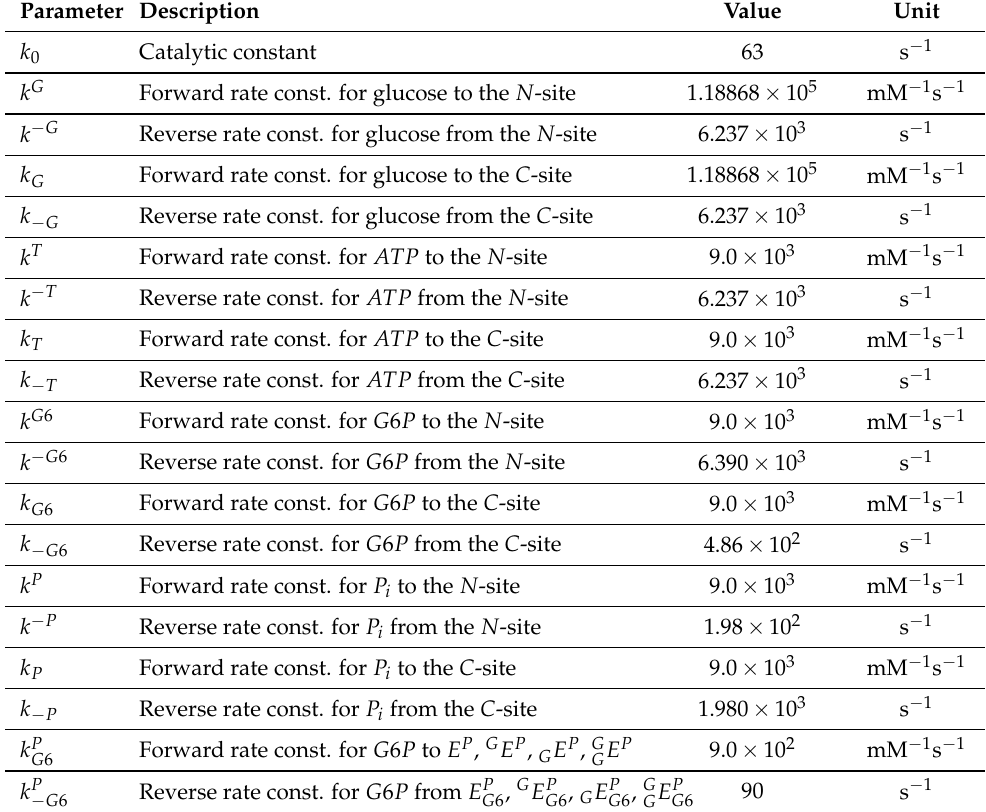
Table 2. Values for the model rate constants.